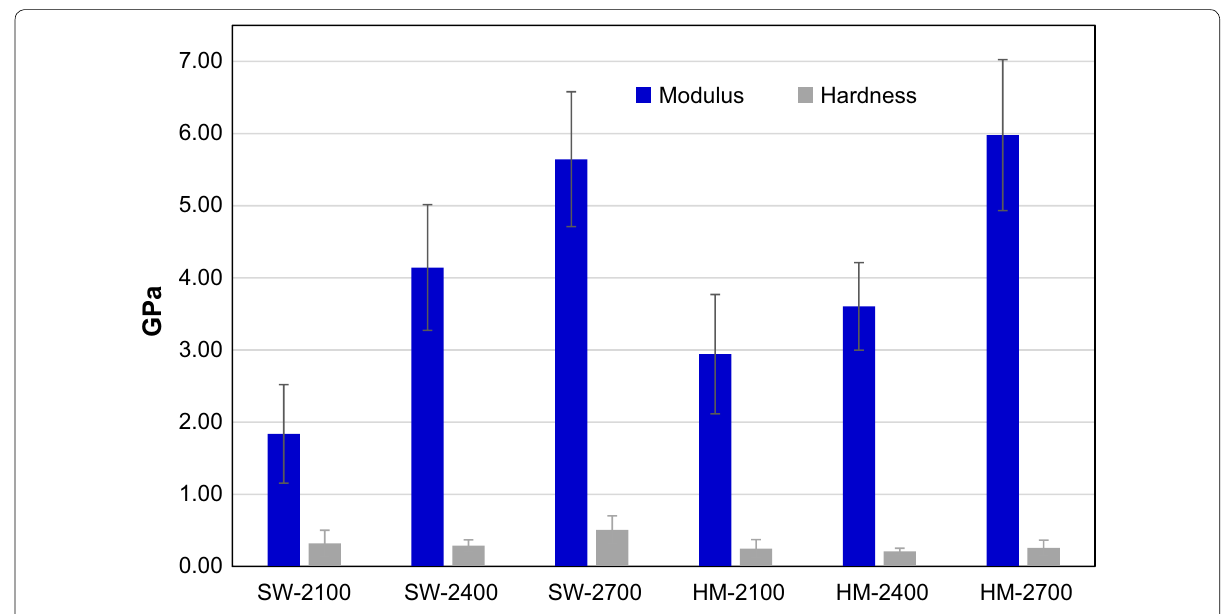
Fig. 7 Hardness and Young’s modulus values for softwood and hemp biochars at different power